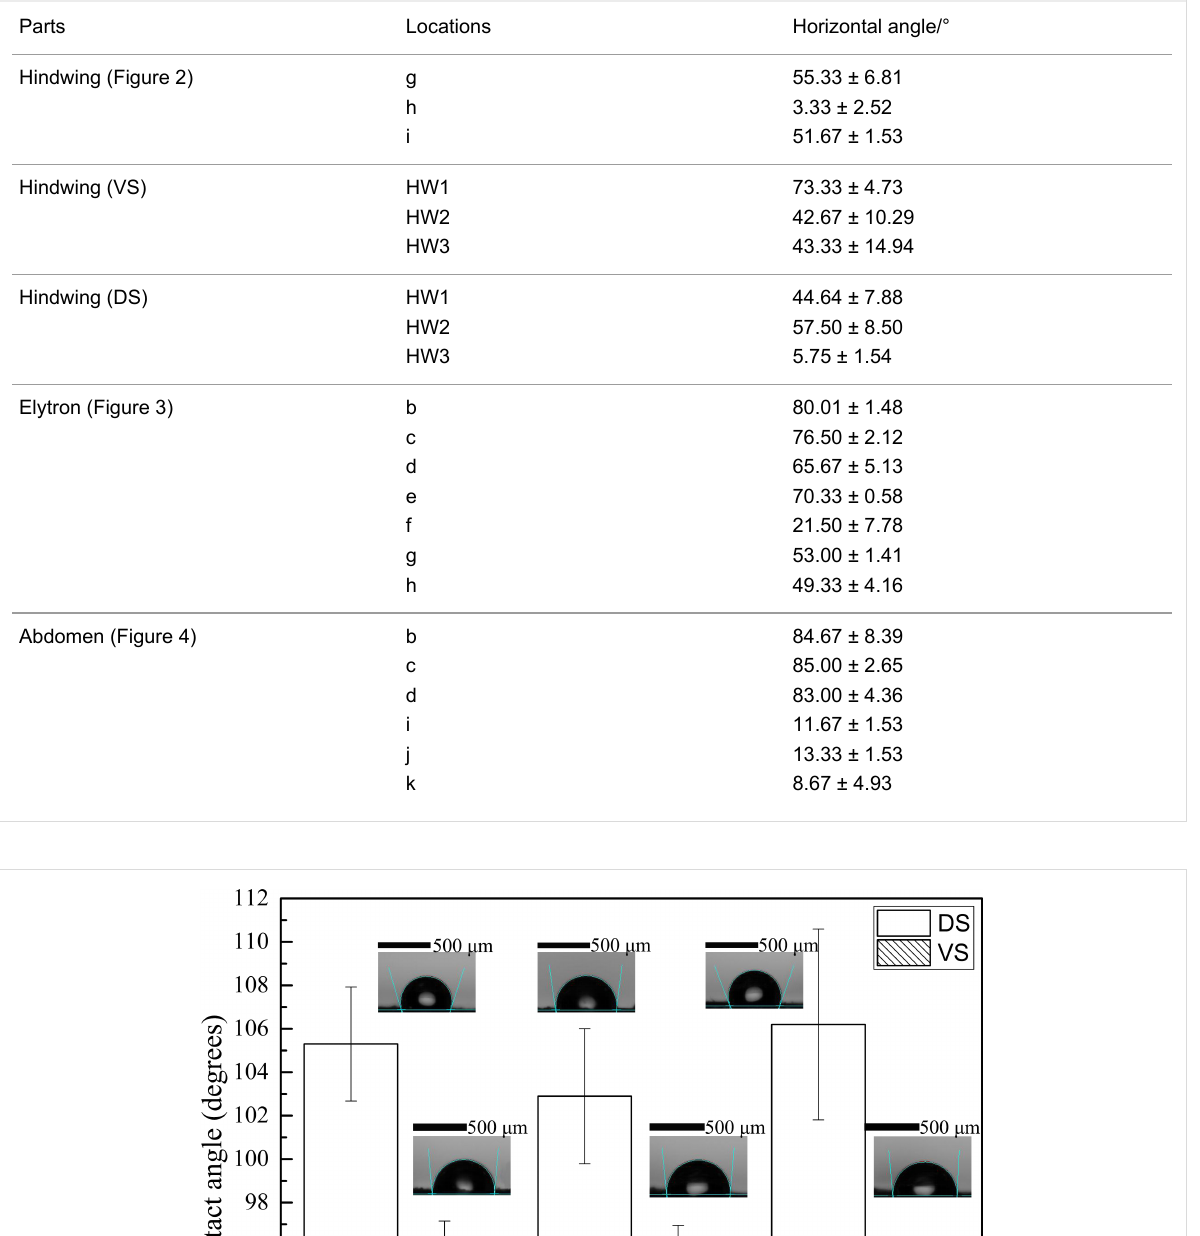
Table 2: Angular orientation of microtrichia on the hindwing, elytron and abdomen of H. axyridis . Parts